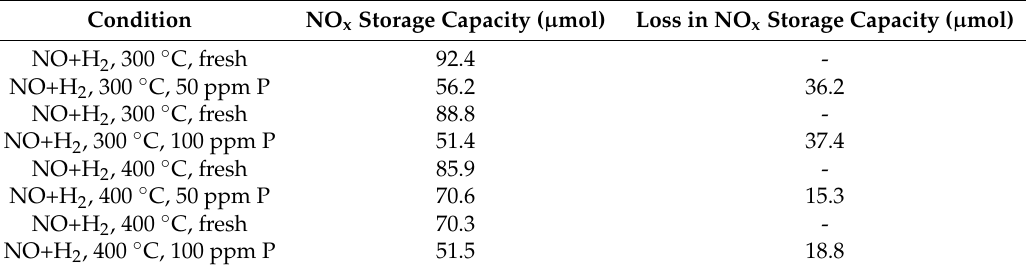
Figure 2. Measured outlet NO x before and after exposing Pt/Ba/Al 2 O 3 to 50 or 100 vol.-ppm H 3 PO 4 , 8 vol.-% O 2 and 5 vol.-% H 2 O for 34 h. The lean phase (400 vol.-ppm NO, 5 vol.-% H 2 O, 5 vol.-% CO 2 and 8 vol.-% O 2 ) starts at time = 0. The rich phase consist of 400 vol.-ppm NO, 5 vol.-% H 2 O, 5 vol.-% CO 2 and H 2 or C 3 H 6 , where ( A ) 300 ◦ C with 1 vol.-% H 2 in the rich phase, ( B ) 300 ◦ C with 0.1 vol.-% C 3 H 6 in the rich phase, ( C ) 400 ◦ C with 1 vol.-% H 2 in the rich phase, and ( D ) 400 ◦ C with 0.1 vol.-% C 3 H 6 in the rich phase. Table 1. NOx storage capacity for fresh and phosphorous exposed